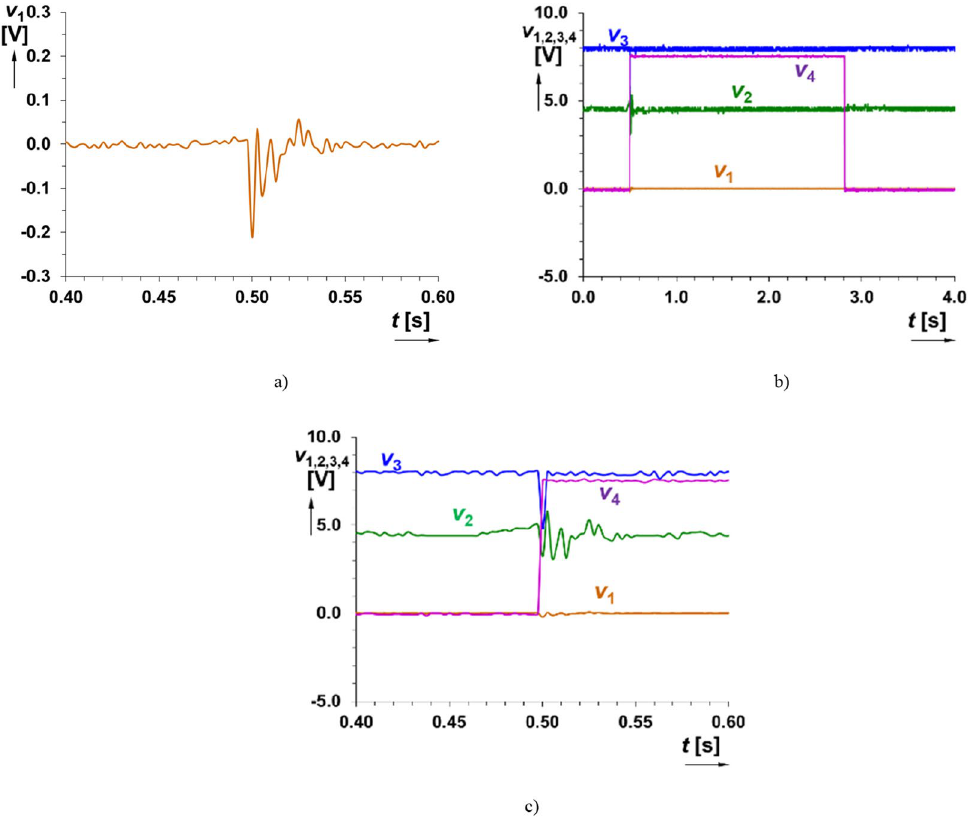
Figure 7. Time domain response of the readout system on handclap: ( a ) detail on the signal at the output of microphone ( v 1 ( t )), ( b ) all indicated outputs of the system and ( c ) detail on